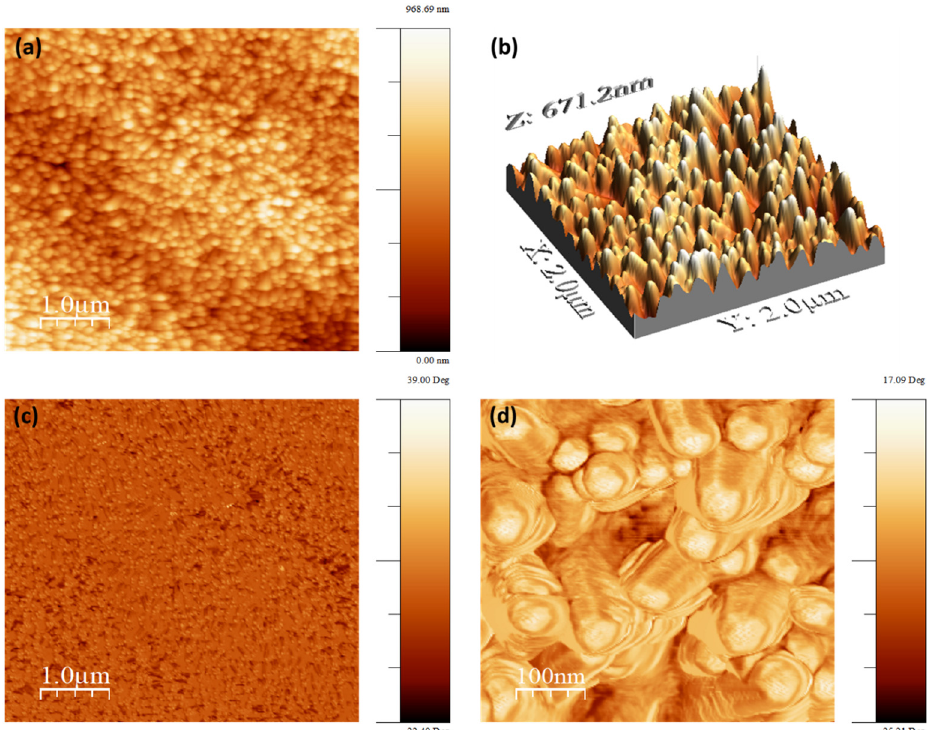
Figure 9. Surface topography ( a ), and the corresponding 3D image ( b ), phase ( c ), and a magnified AFM phase image ( d ), of ZnO nanorods grown at 90 °C for 24 h, obtained using atomic force microscopy (AFM).